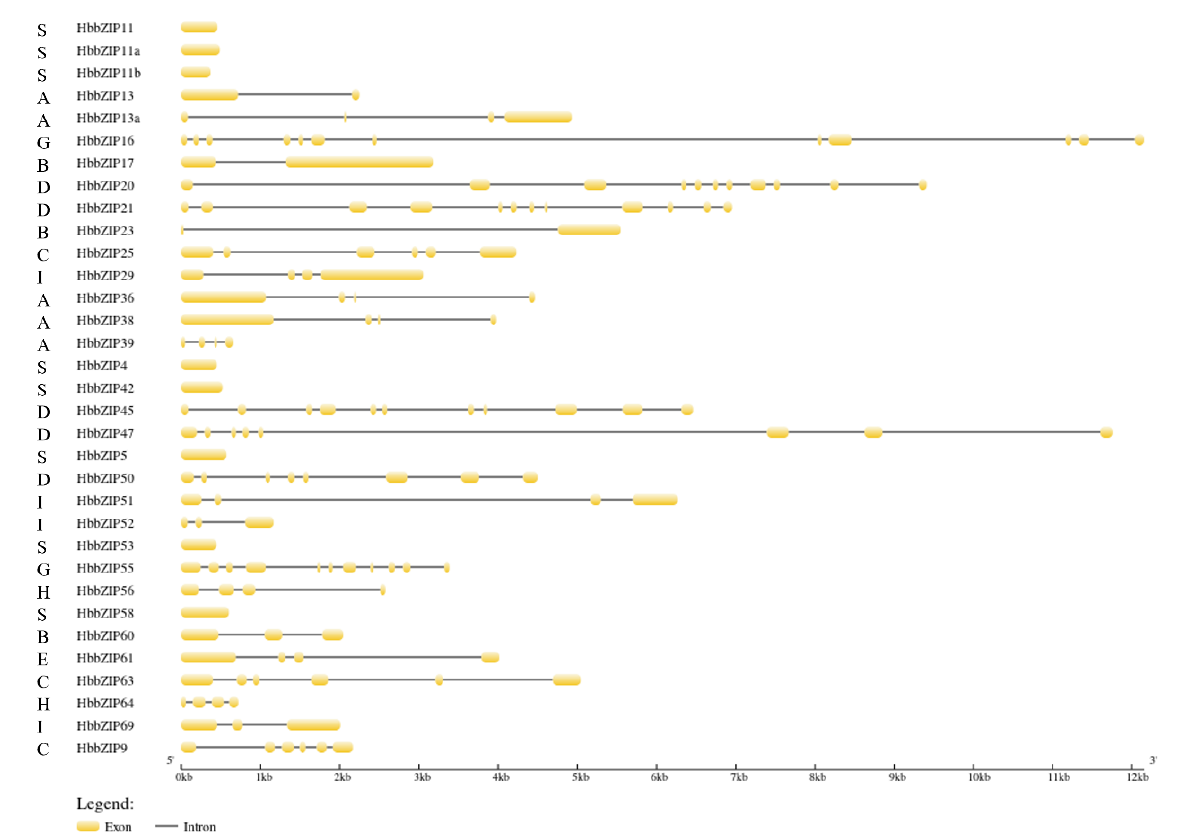
Figure 3. Exon – intron structure of 33 HbbZIP genes in rubber trees. Figure 3. Exon–intron structure of 33 HbbZIP genes in rubber trees.